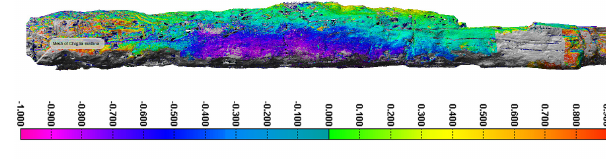
Figure 4. Colour coding showing the dimensional variations between morning and afternoon.